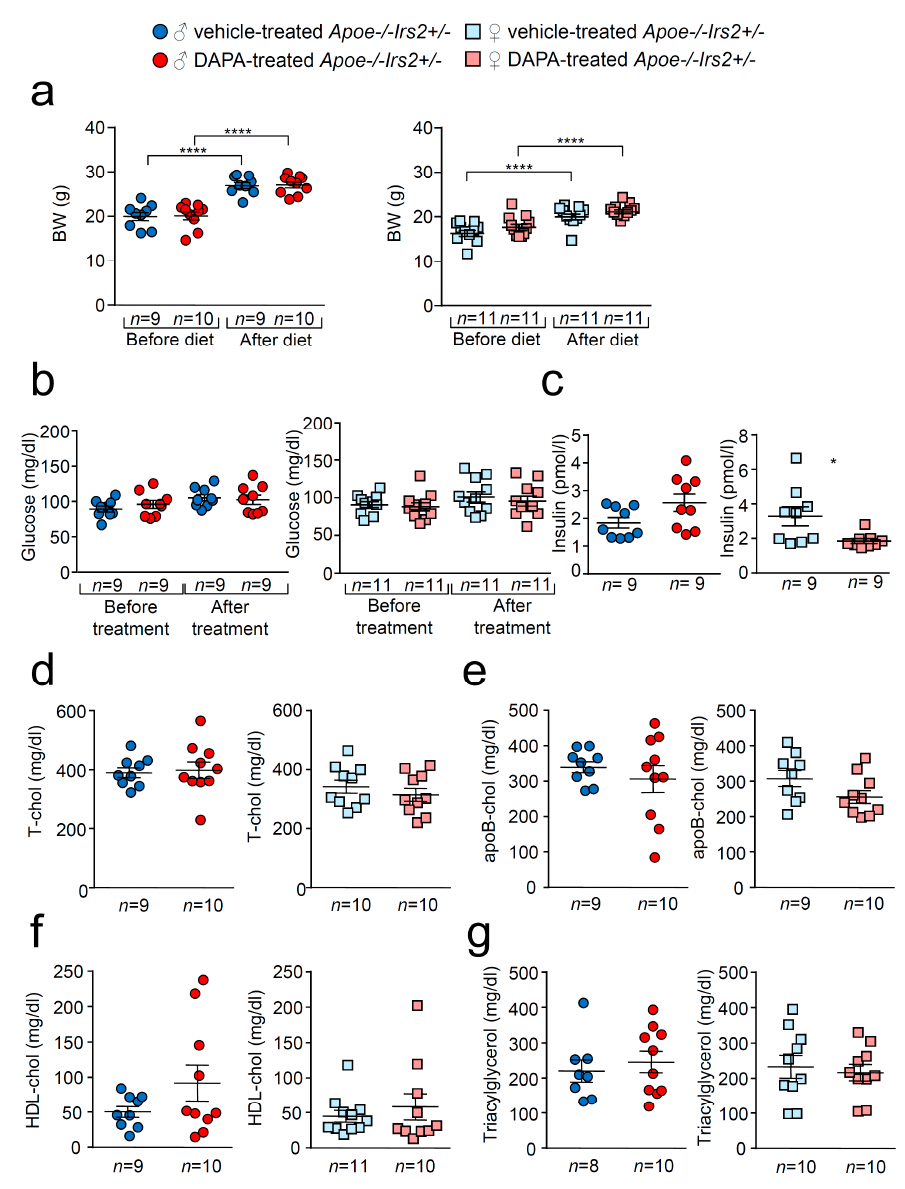
Figure 1. Effect of DAPA treatment in Apoe − / − Irs2+/ − mice. ( a ) Body weight (BW) before and after atherogenic diet in male (left panel) and female (right panel) vehicle-treated and DAPA-treated Apoe − / − Irs2+/ − mice. ( b ) Fasting plasma glucose levels in male (left panel) and female (right panel) vehicle-treated and DAPA-treated Apoe − / − Irs2+/ − mice. ( c ) Fasting insulin levels in male (left panel) and female (right panel) vehicle- and DAPA-treated mice after treatment. ( d ) Total-cholesterol, ( e ) apoB-cholesterol, ( f ) HDL-cholesterol and ( g ) triacylglycerol levels in male (left panel) and female (right panel) DAPA- and vehicle-treated Apoe − / − Irs2+/ − mice. Data are represented as individual points with mean ± sem. The statistical analysis for normal distribution was D’Agostino–Pearson and for differences was two-way ANOVA followed by Bonferroni’s post-hoc test ( a , b ), Student’s t -test ( c , f , left panel), ( d , e ) and ( g , right panel), and Mann–Whitney U test ( c , f , right panel) and ( g , left panel). **** p < 0.0001. * p < 0.05.